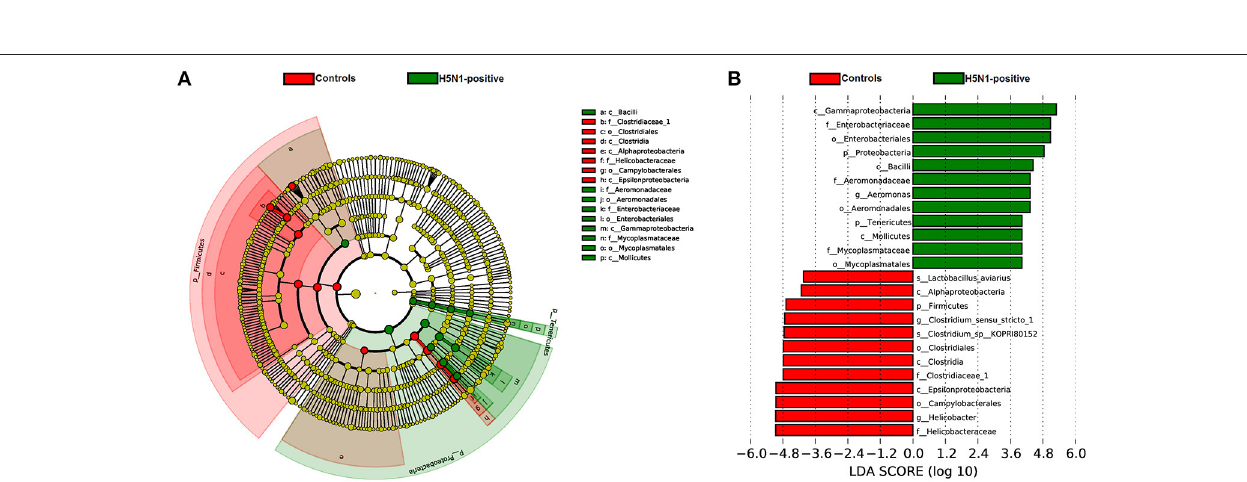
FIGURE 5 | The taxa whose abundance differed between the H5N1-infected individuals and the healthy controls were identified by LEfSe. (A) Taxonomic cladogram obtained from LEfSe analysis of sequences (relative abundance ≥ 0.5%). Biomarker taxa are highlighted by colored circles and shaded areas (H5N1-positive samples are shown in green, and healthy control samples are shown in red). Each circle’s diameter reflects the abundance of that taxa in the community. (B) The taxa whose abundance differed between the H5N1-infected samples (green bars) and the healthy control samples (red bars). The cutoff value of ≥ 2.0 used for the linear discriminant analysis (LDA) is